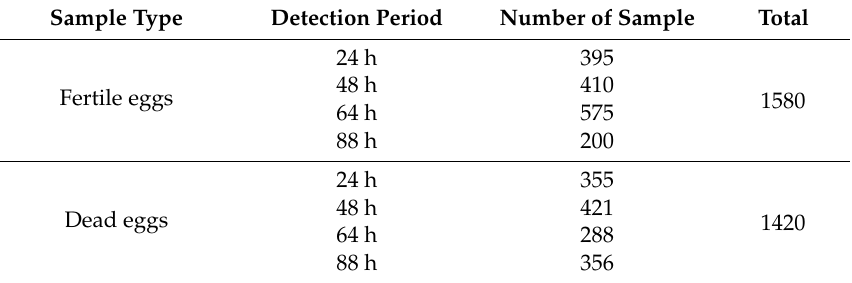
Table 5. Test set sample distribution.